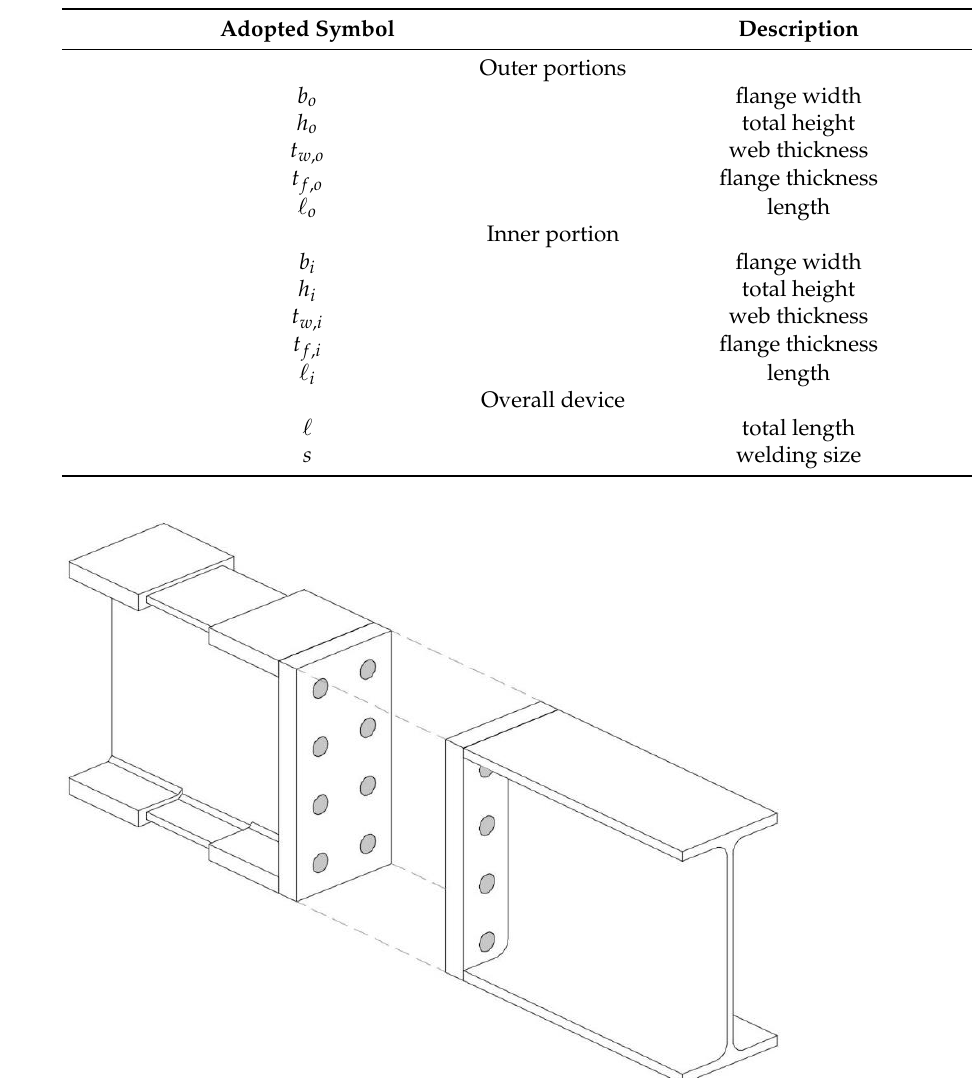
Table 2. Geometrical characteristics of the device.